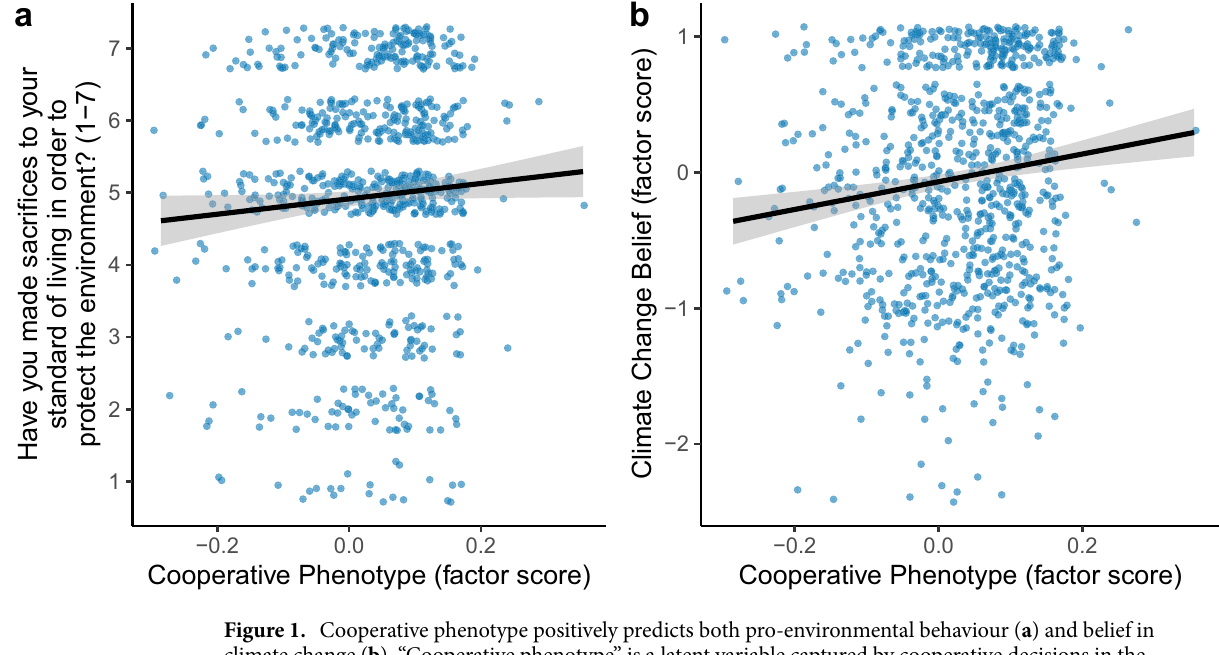
Figure 1. Cooperative phenotype positively predicts both pro-environmental behaviour ( a ) and belief in climate change ( b ). “Cooperative phenotype” is a latent variable captured by cooperative decisions in the Dictator Game, Public Goods Game, Trust Game, and Stag Hunt Game. “Climate change belief” is a latent variable captured by three self-report items measuring belief in the reality of climate change, belief that climate change is human caused, and concern about climate change. For visualisation ease, regression lines and 95% confidence interval shaded areas are predictions from least-squares regressions without covariates.